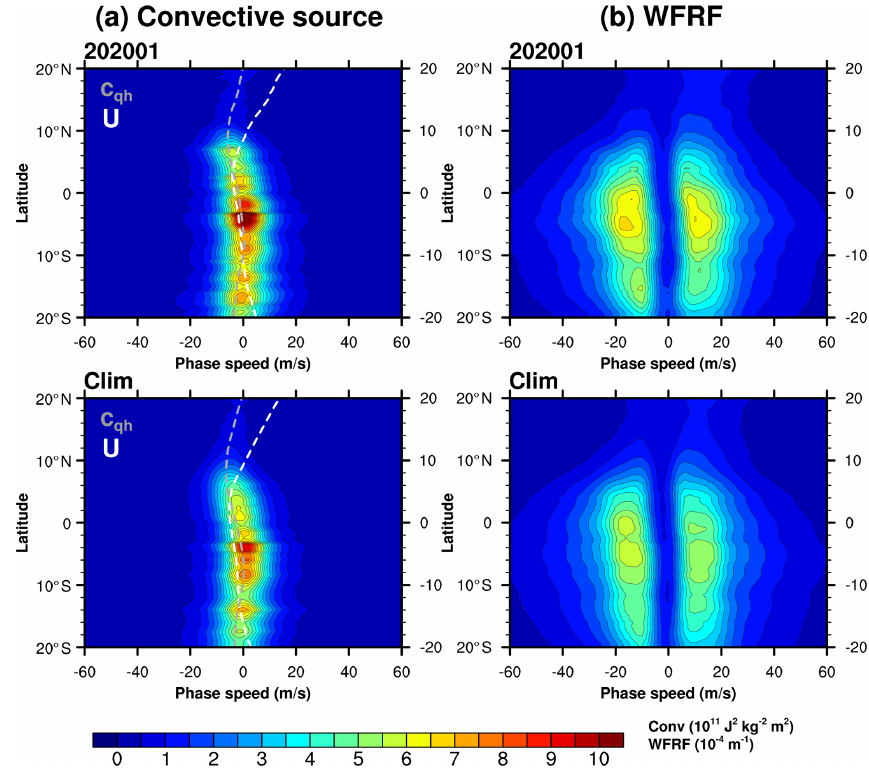
Figure 13. Phase-speed spectrum of the (a) convective source and (b) wave-filtering and resonance factor (WFRF) in (top) January 2020 and (bottom) and its climatology as a function of the latitude between 20 ◦ N and 20 ◦ S. Zonal-mean zonal wind at the cloud top ( U ct ) and moving speed of convection ( c qh ) are denoted by white and gray dashed lines, respectively, in the convective source